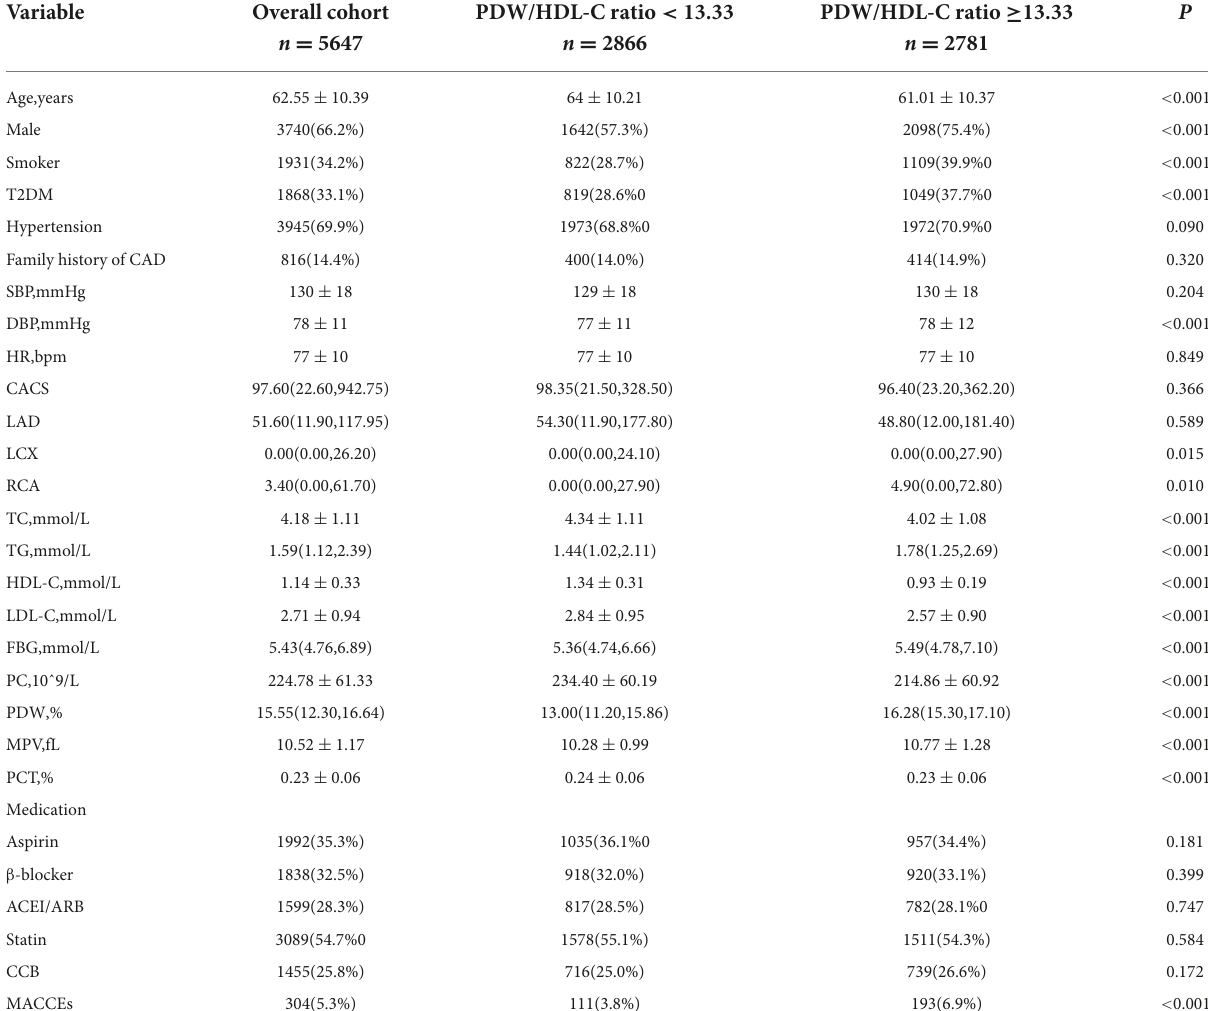
TABLE 2 Comparison of baseline characteristics between high and low ratio groups. Variable Overall